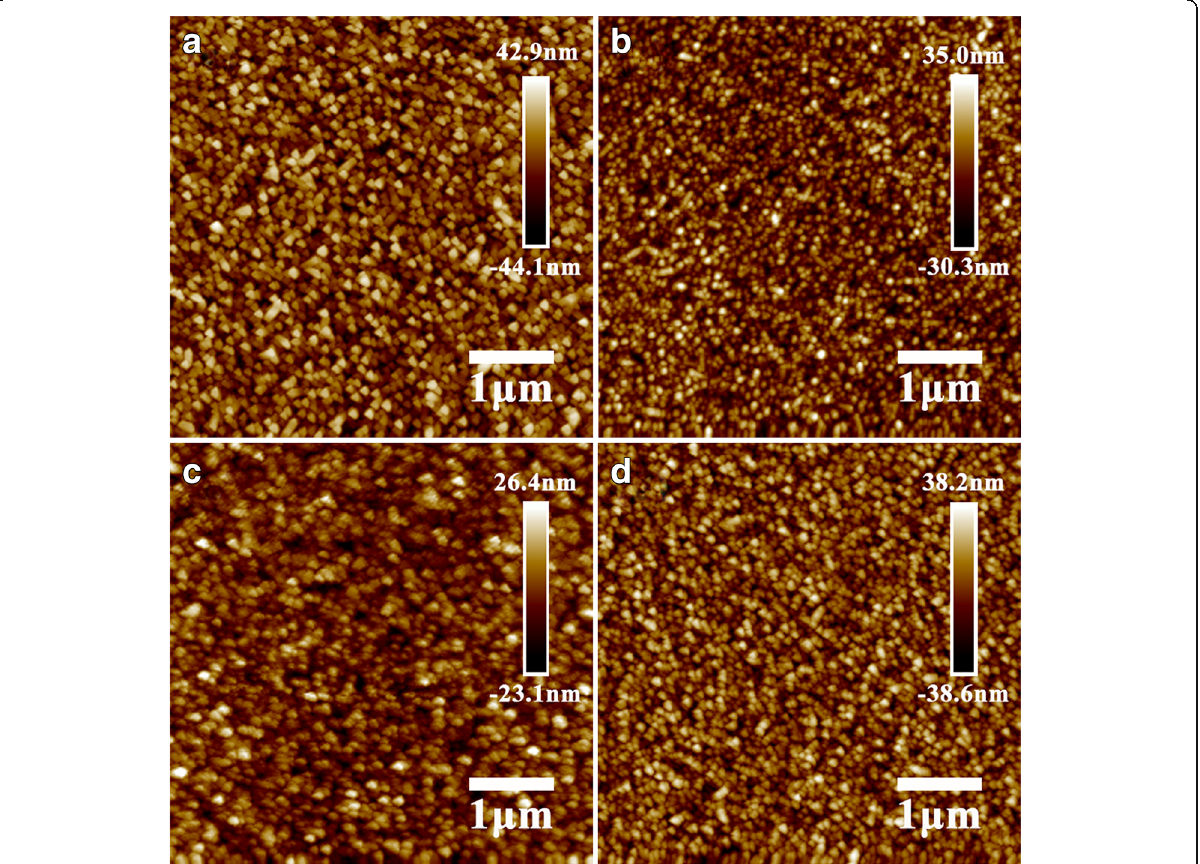
Fig. 1 AFM images of a bare FTO, b c-TBOT, c c-TTIP, and d